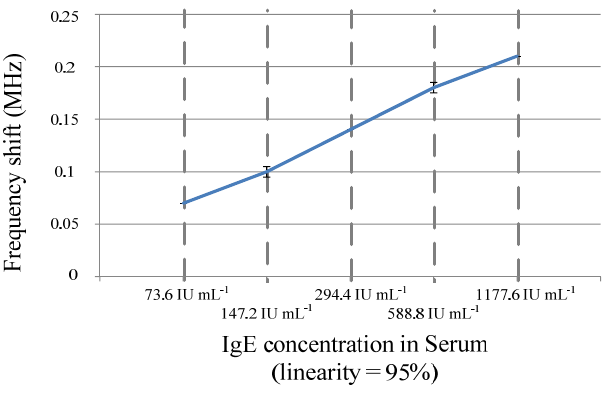
Figure 20. Frequency shift versus IgE concentration.